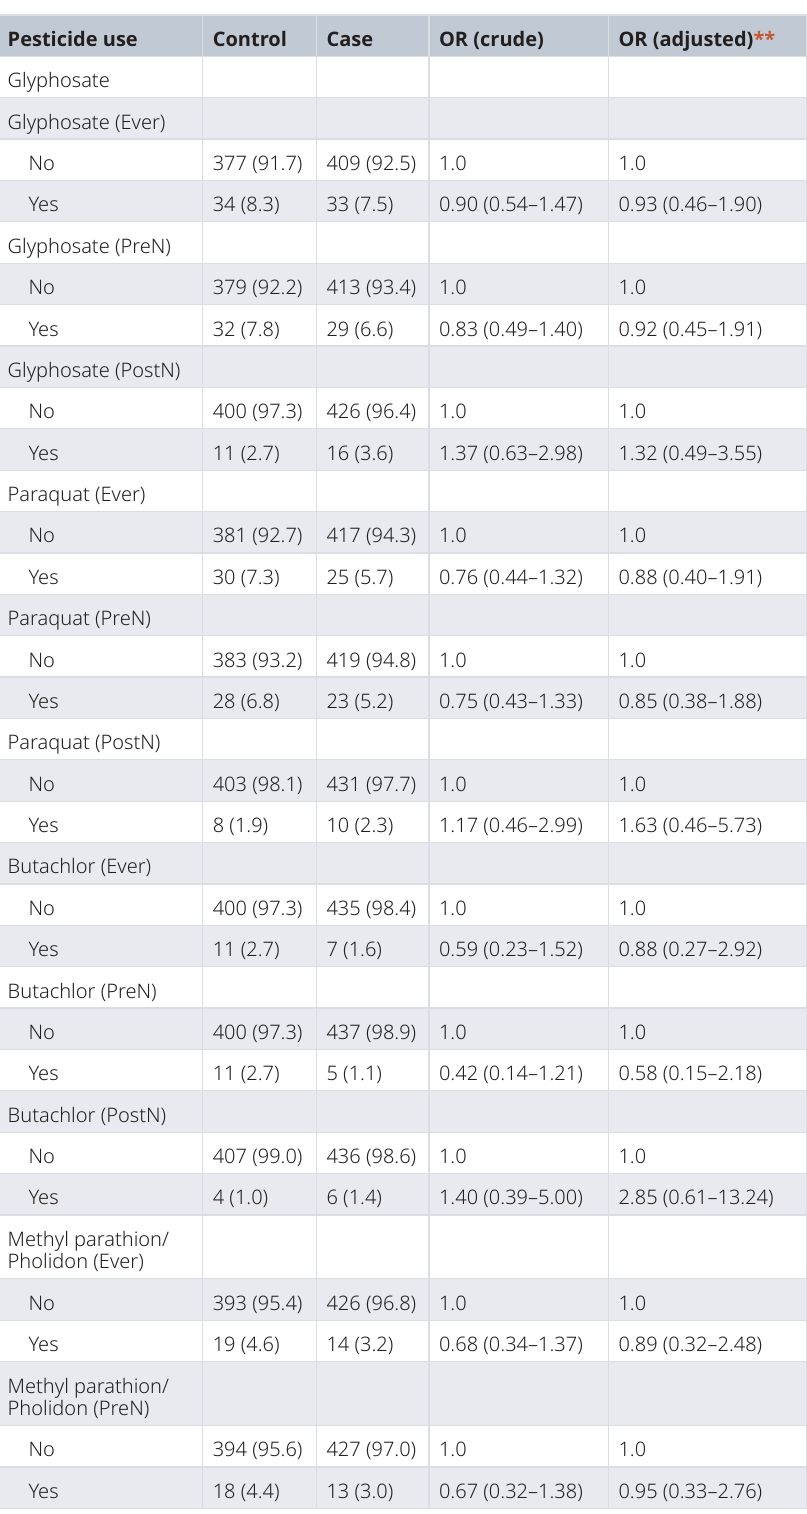
Table 3. Individual pesticide exposure of case and control and risk of suspected developmental